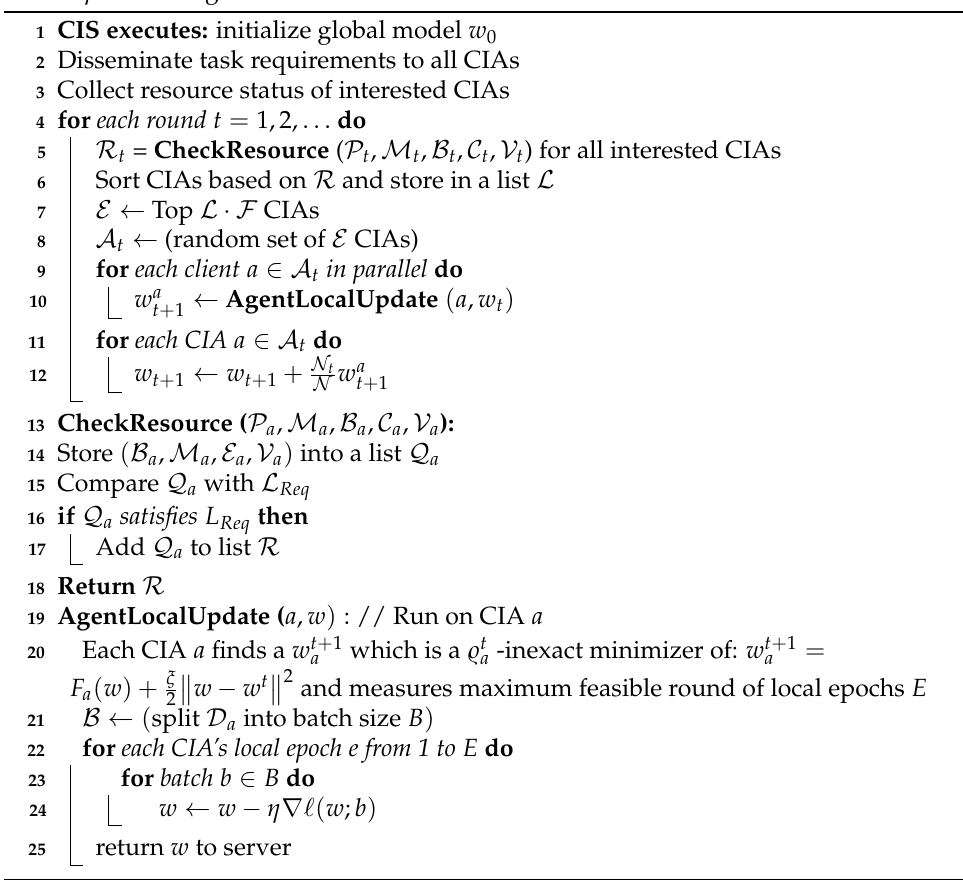
Algorithm 1: FedResilience: An FL-based approach to predict the outages and resource-sharing scopes of critical infrastructures. The A eligible